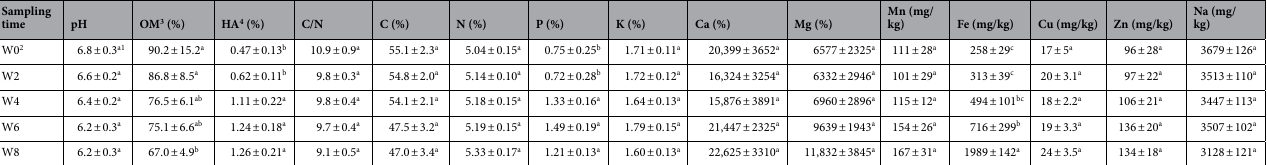
Table 4. The chemical properties of soybean manure at different sampling stage. 1 Different letters indicate significantly different results by LSD tests at p < 0.05. 2 0, 2, 4, 6, 8 week after compost. 3 Organic matter. 4 Humic acid.